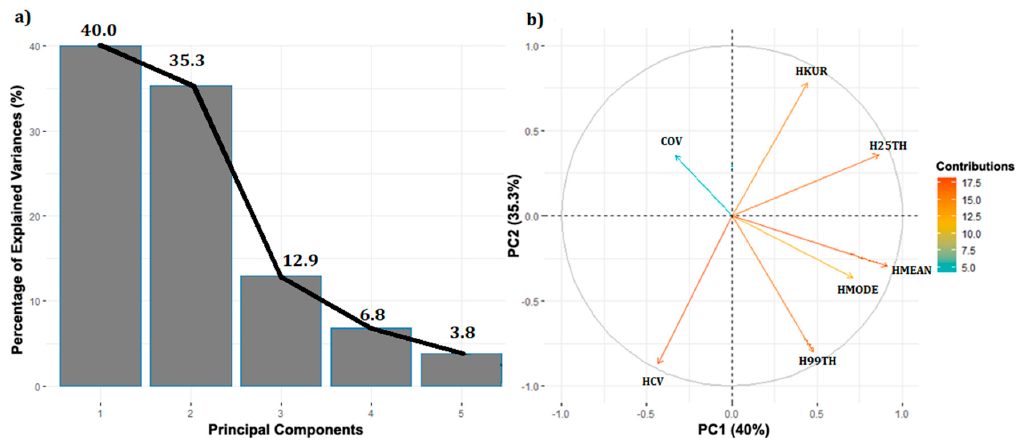
Figure 2. ( a ) The percentage of variance explained by the five PCs. ( b ) Projection of the first two PC scores from the selected LiDAR metrics. Different colors represent the variable contribution.